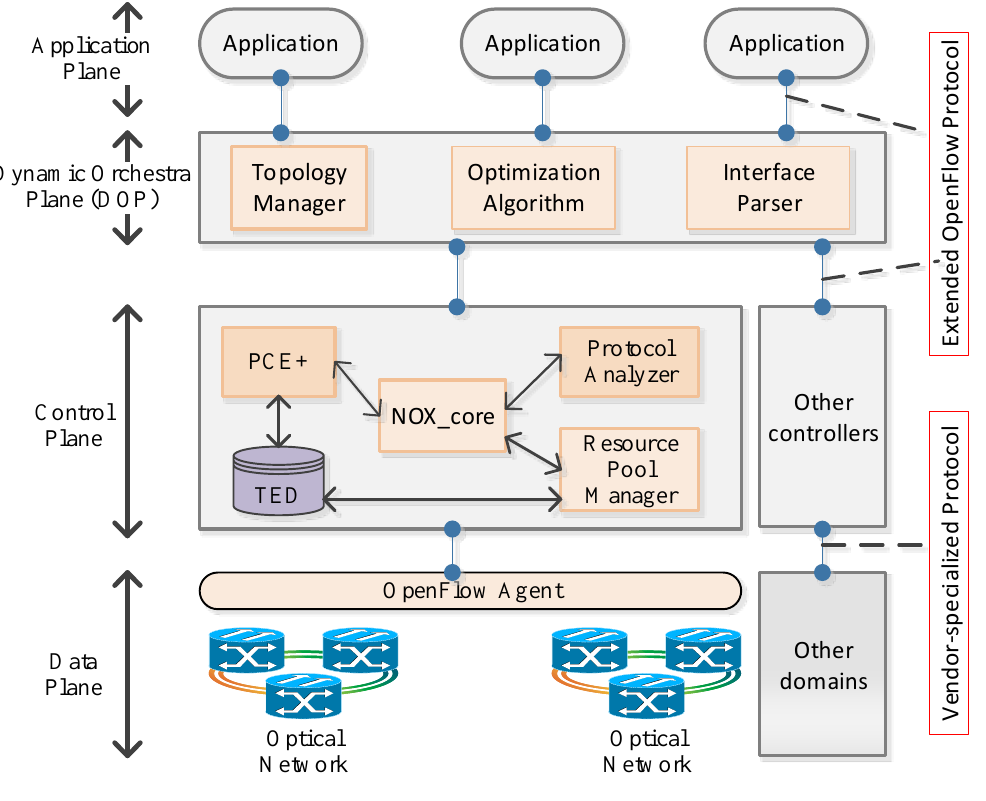
Figure 1. The architecture of